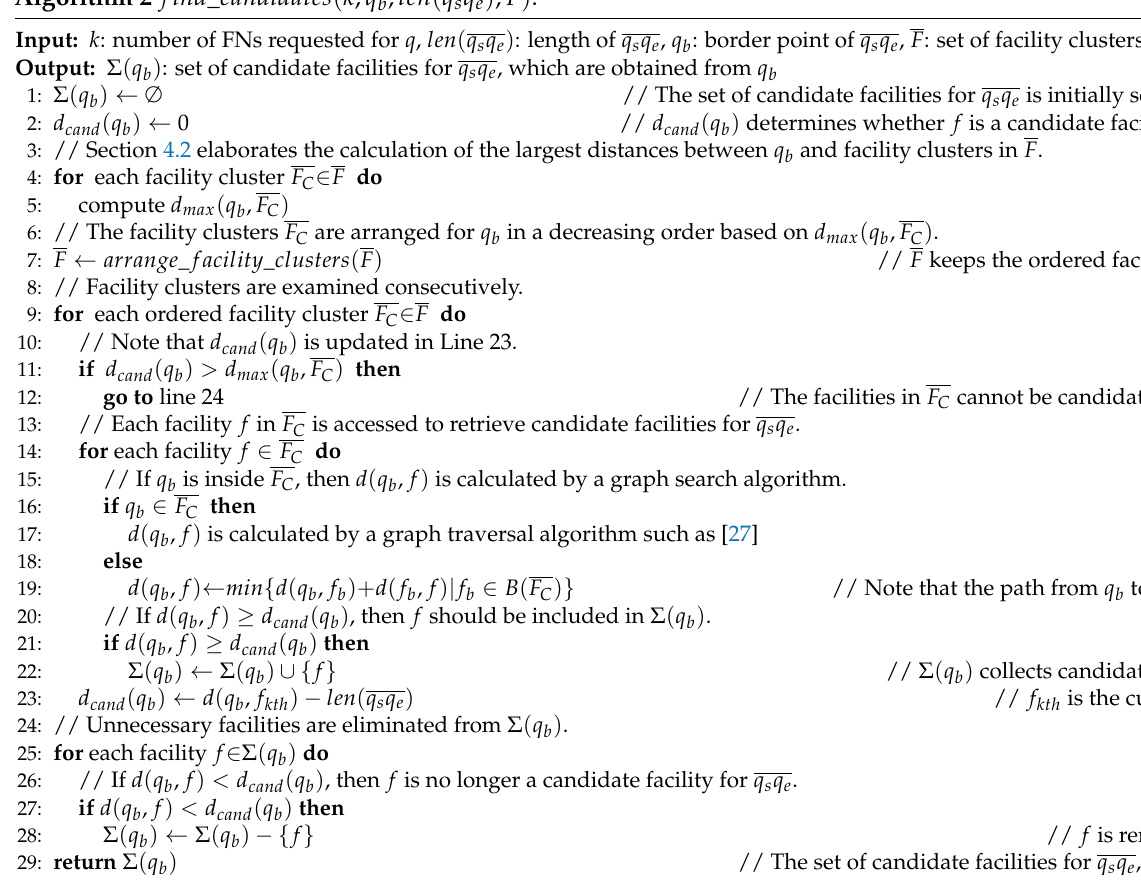
Algorithm 2 f ind _ candidates ( k , q b , len ( q s q e ) , F )